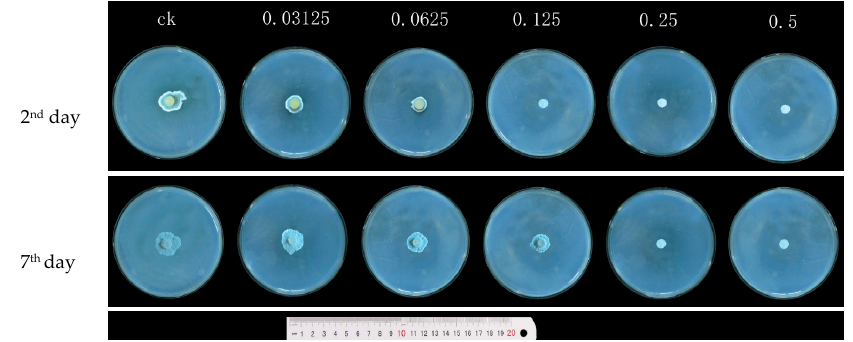
Figure 2. The e ff ect of the growth diameter of P. digitatum treated with di ff erent concentrations of Figure 2. The effect of the growth diameter of P. digitatum treated with different concentrations of carvacrol (0, 0.03125, 0.0625, 0.125, 0.25, and 0.50 mg / mL) at 2 days and 7 days post-inoculation (dpi).